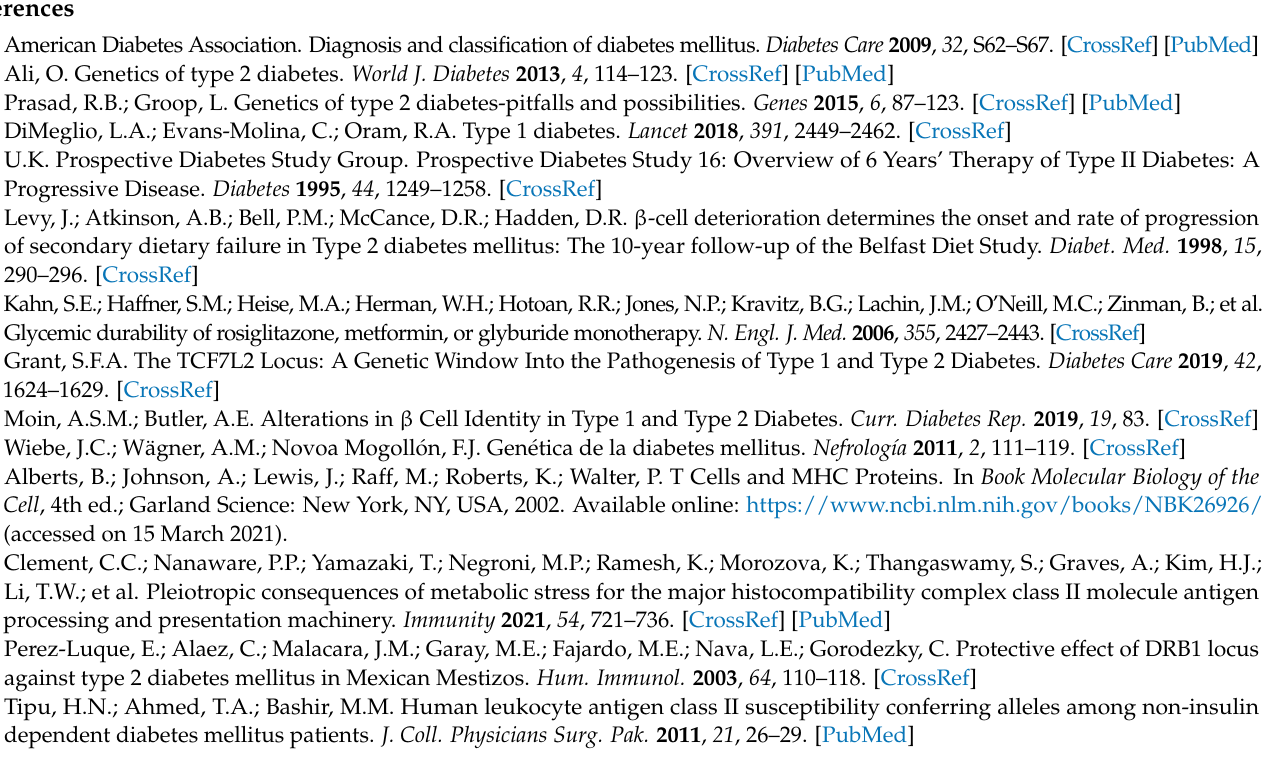
worldwide populations. Figure S4: HLA-A and HLA-C differential expression values from muscle tissue. Figure S5. Fisher’s exact test of the expression values obtained from the group with Type 2 Diabetes (DT2) compared to a control group with a positive family history for DT2 and a control group with a negative family history for